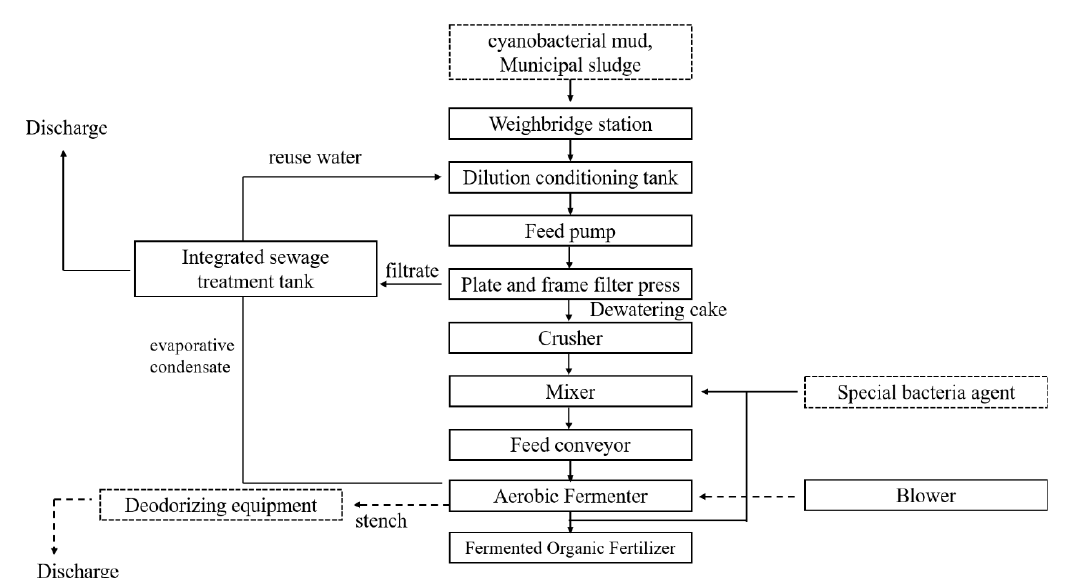
Figure 3. Schematic diagram of the process flow of aerobic fermentation without auxiliary materials.